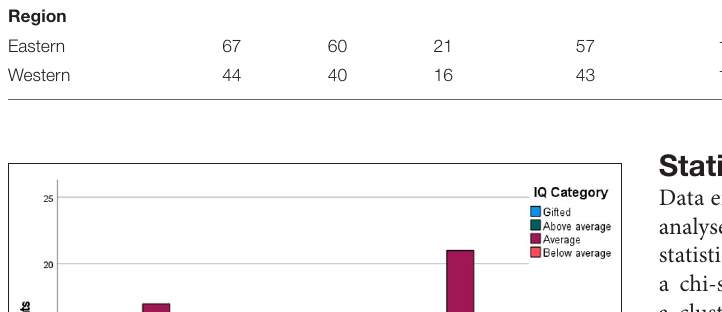
Overall, 111 participants were included in the IQ analysis and BMI calculation comparison ( n = 37, 22, and 52 for exclusively breastfed, exclusively bottle-fed, and mixed-fed, respectively). However, only 102 participants were included in the SI analysis ( n = 37, 20, and 45 for exclusively breastfed, exclusively bottle-fed, and mixed-fed,